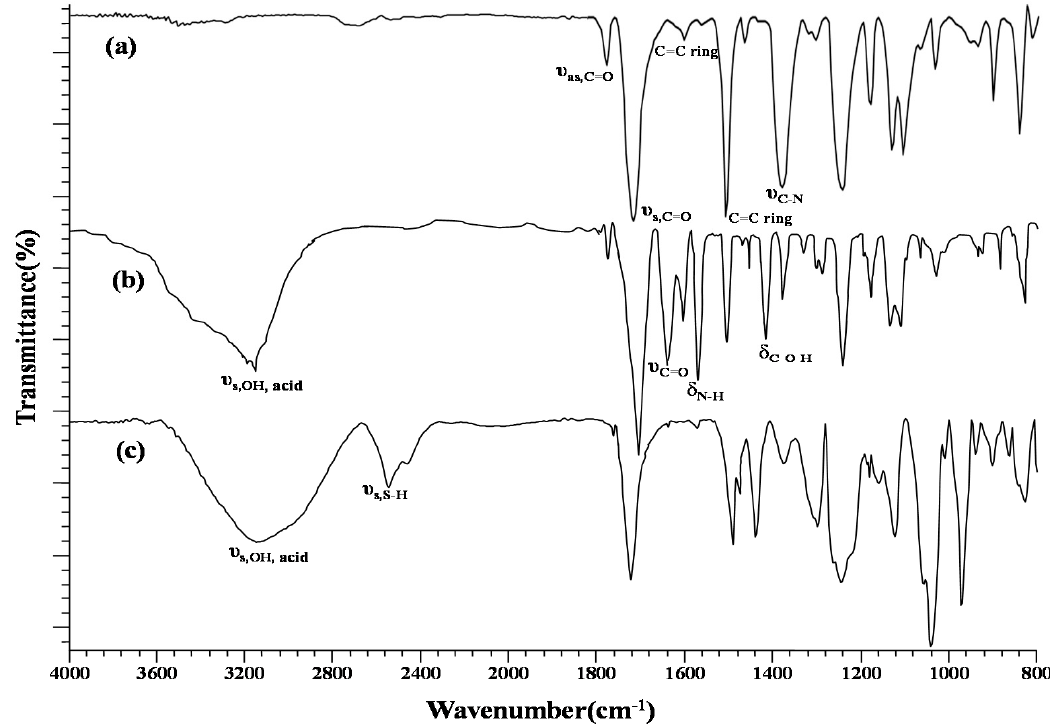
, × ), acid ( γ + , (cid:72) ), S S ), of the (cid:35)